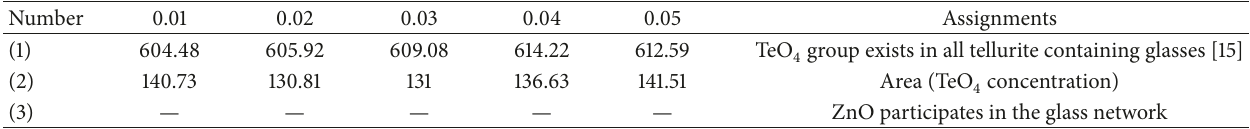
— ZnO participates in the glass network